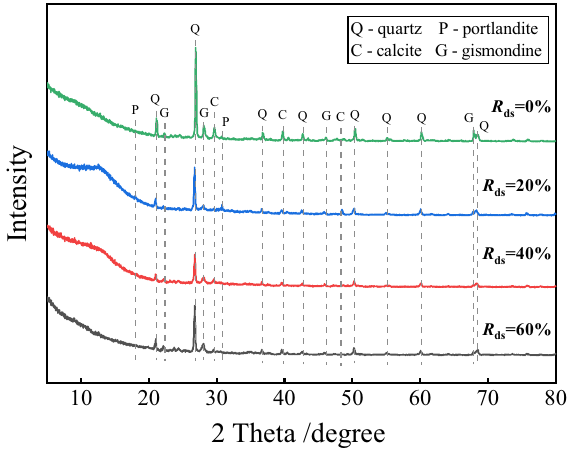
Figure 14. XRD patterns of different desert sand replacement rates.